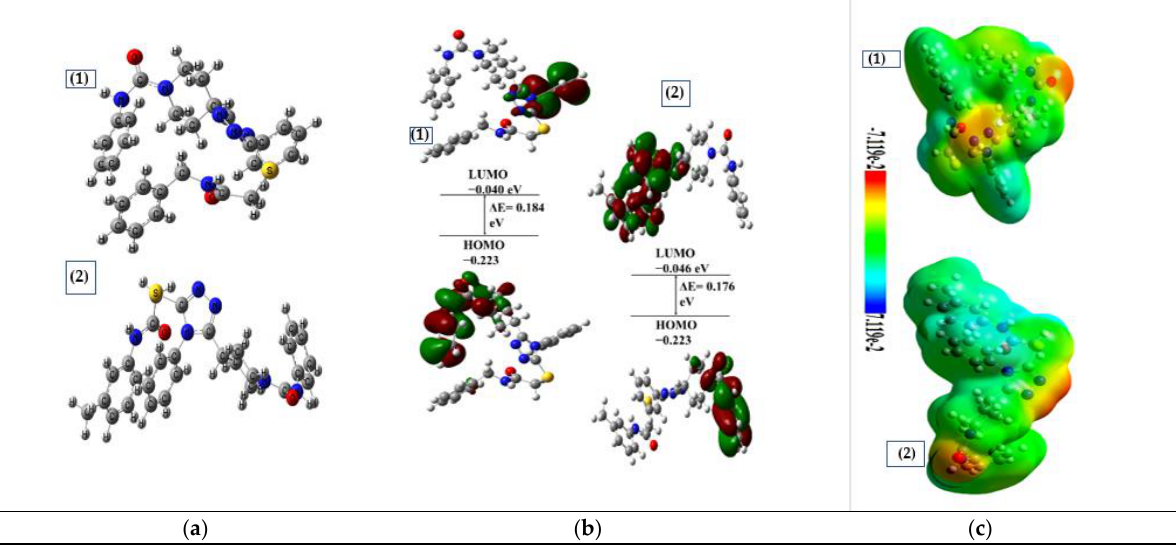
Figure 3. ( a ) Optimized structures in gas phase. ( a1 ) Compound 7d , ( a2 ) Compound 7f , ( b ) HOMO LUMO structures in gas phase. ( b1 ) Compound 7d , ( b2 ) Compound 7f , ( b ) Representation of Electrostatic potential (ESP) in gas phase. (1) Compound 7d , (2) Compound 7f . Table 1. Optimized geometric parameters for compounds by using B3LYP/SVP DFT method in both gas and in solvent phase (ethanol).